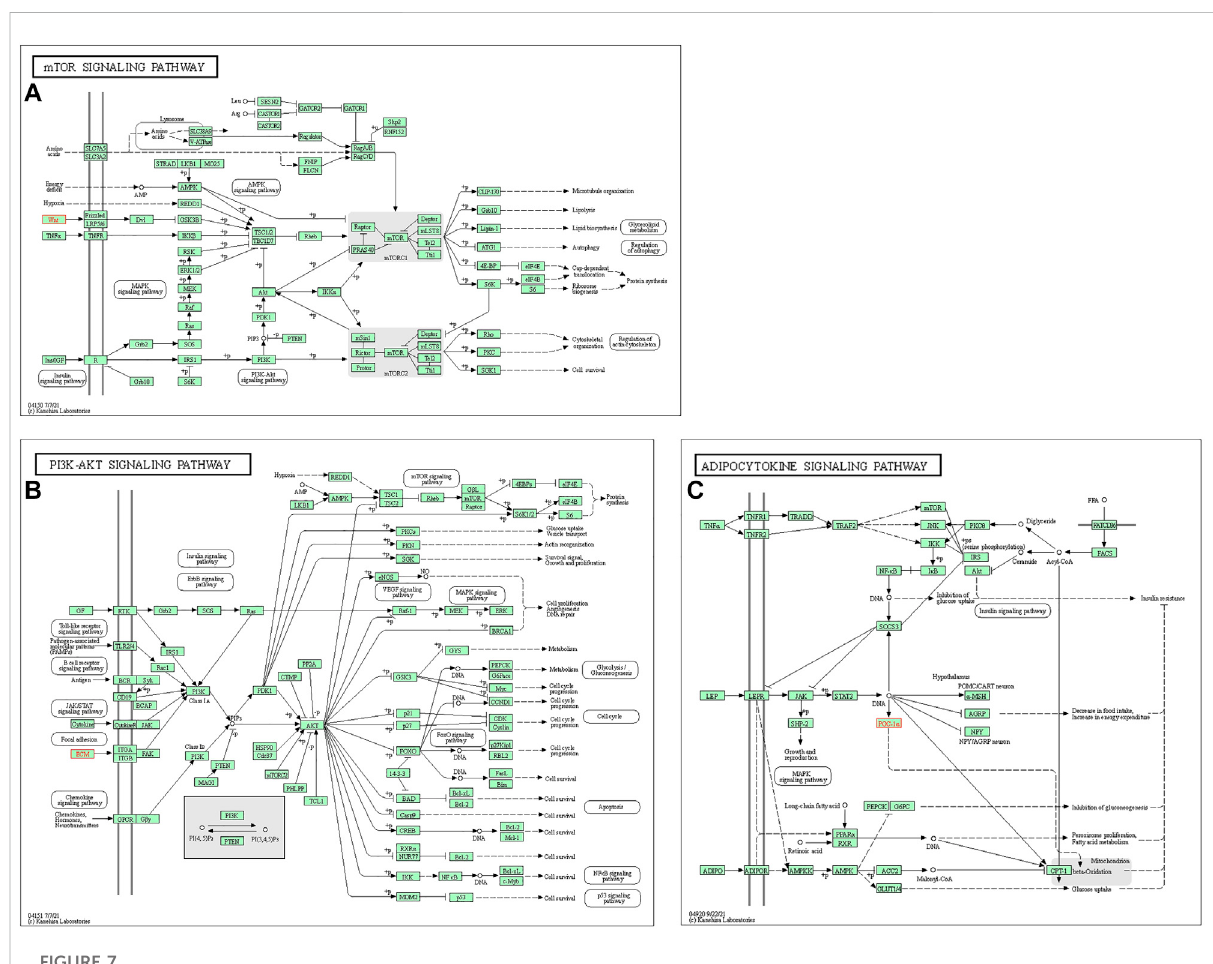
FIGURE 7 Mapping of the signaling pathways. (A) mTOR signaling pathway related to WNT5A. (B) PI3K-AKT signaling pathway related to COL1A1. (C) ADPOCYTOKINE signaling pathway related to PPARGC1A.